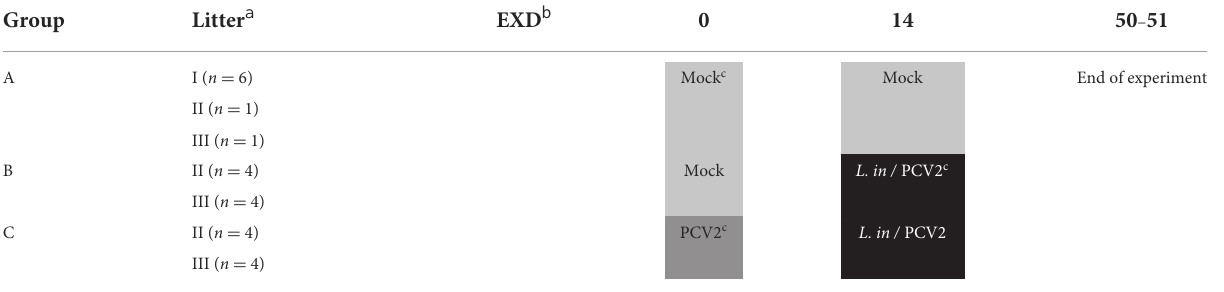
TABLE 1 Experimental design of the delayed co-infection